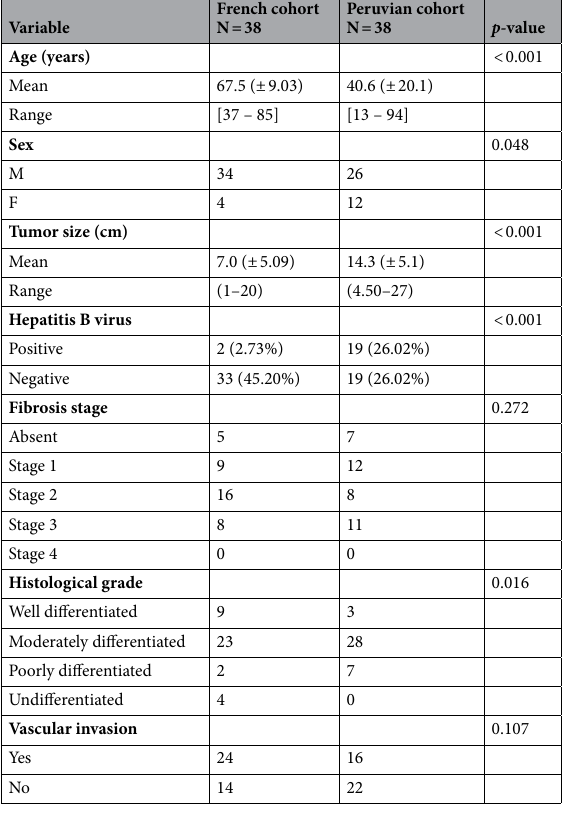
Table 1. Main clinical features of patients included in the Peruvian and French cohorts. For numerical variables, mean values are presented with ± standard deviation (SD). For categorical variables, data are presented as number of cases. Levels of significance ( p < 0.05) were calculated with Mann Whitney U-test.